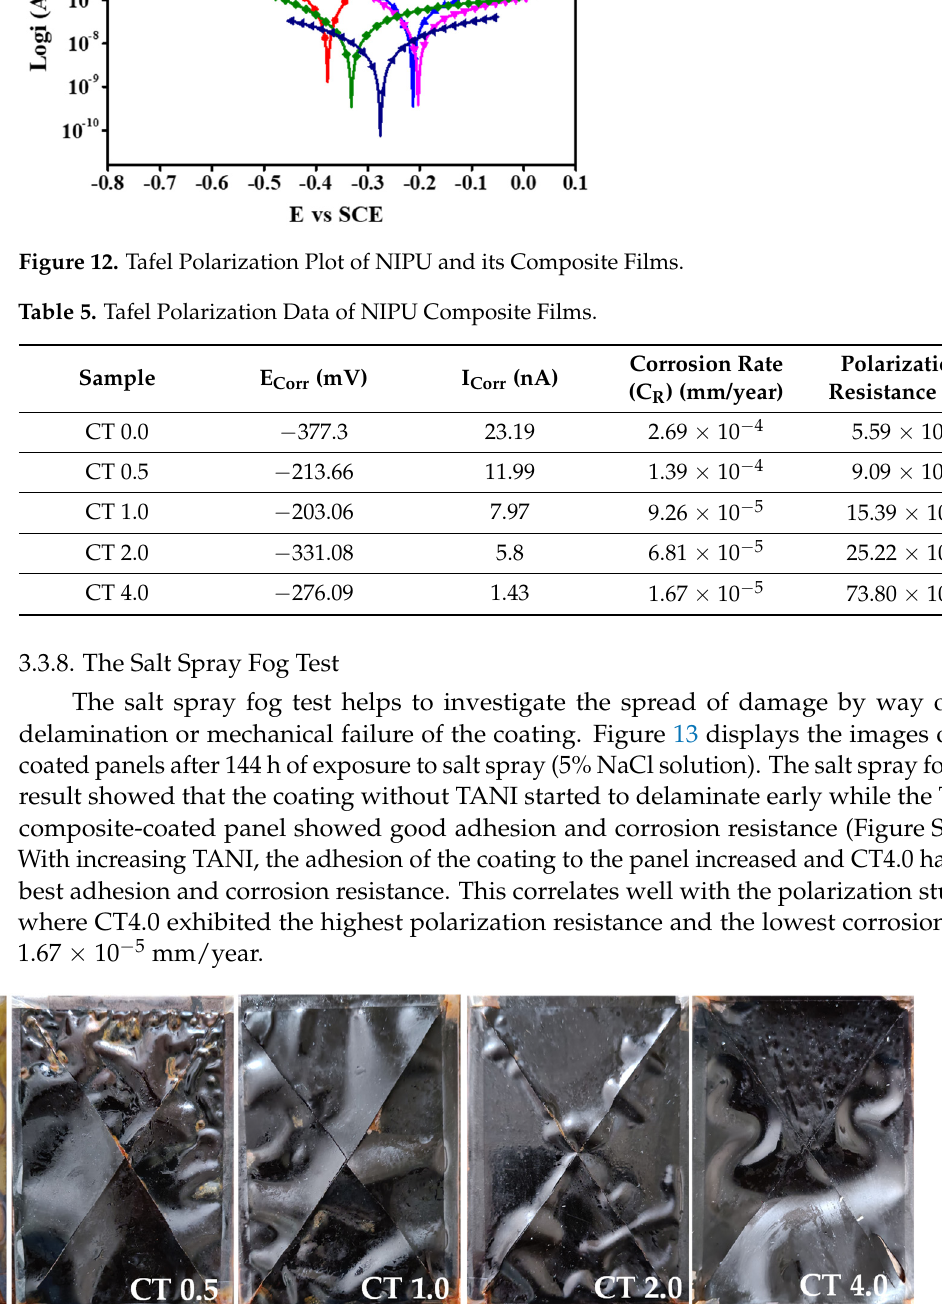
Table 5. Tafel Polarization Data of NIPU Composite Films .